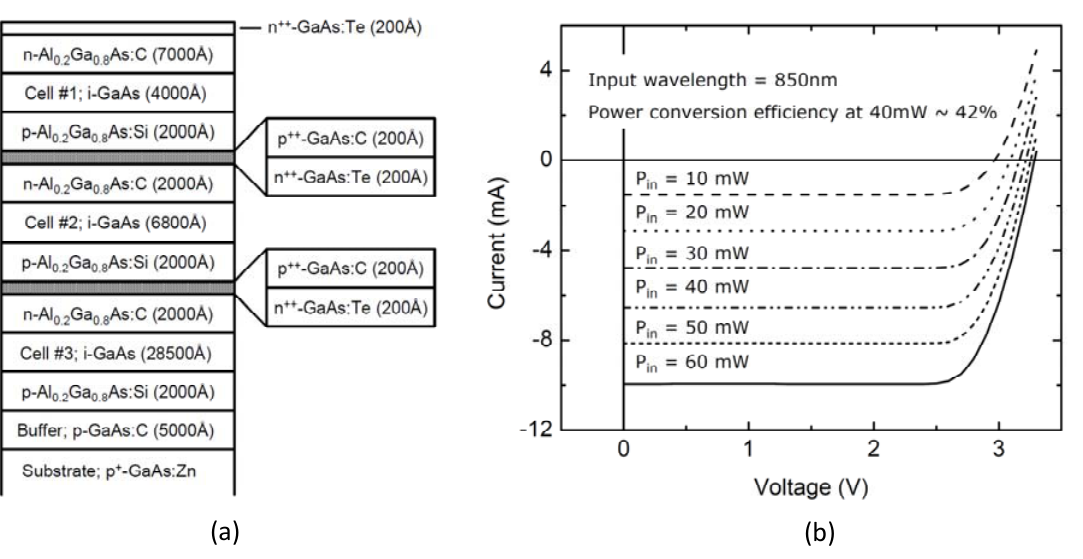
Figure 5. Schematic of the GaAs/AlGaAs heterostructures for a photovoltaic energy converter device ( a ), and current-voltage characteristics of a fully packaged photovoltaic energy converter device under various levels of optical illumination ( b